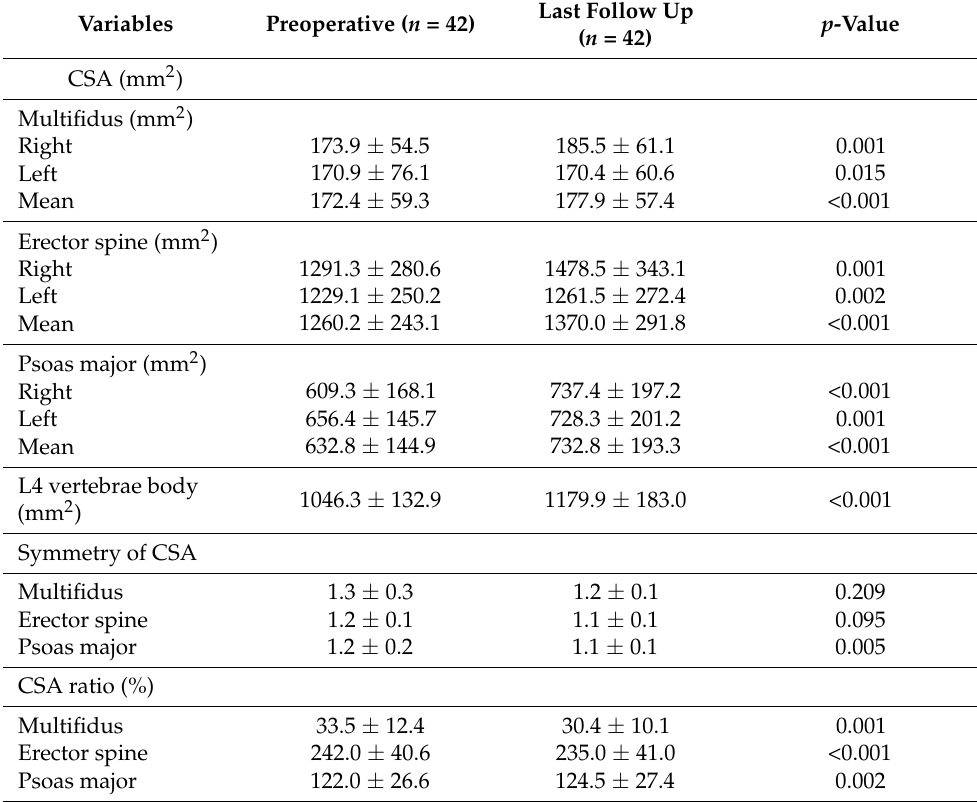
Table 3. Longitudinal comparison of paraspinal muscle cross-sectional areas between preoperative and last follow-up data. Variables